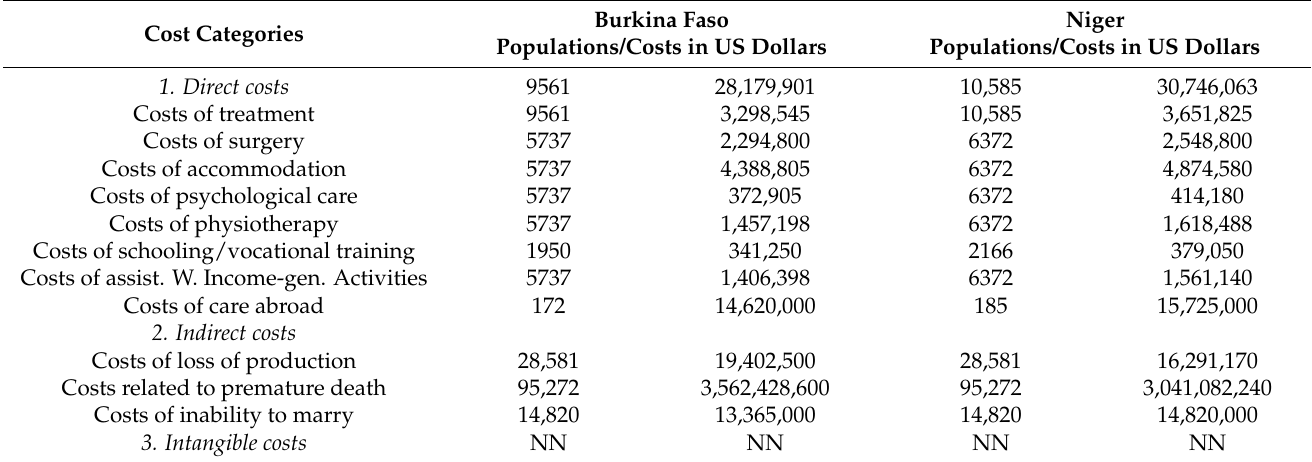
Table 6. Summary of economic and social costs of noma in Burkina Faso and